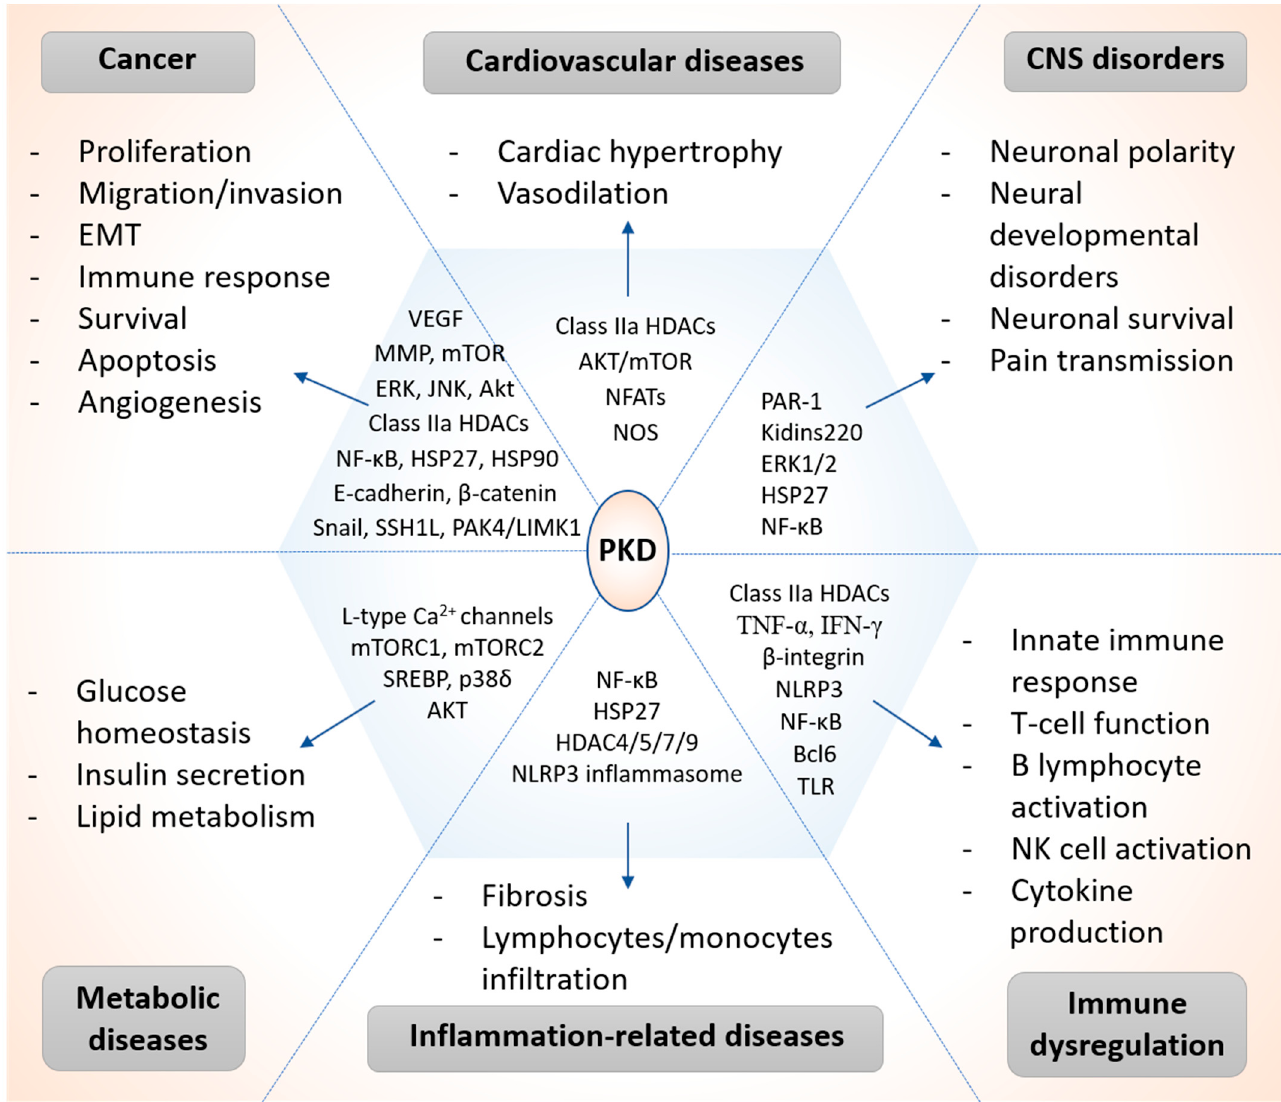
Figure 3. Versatile roles of PKD in human diseases. Schematic representation of key roles and major signaling targets of PKD in the pathogenesis of cancer and other human diseases. Abbreviations: central nervous system (CNS), epithelial-to- mesenchymal transition (EMT), natural killer (NK) cell, Toll-like receptor (TLR), nuclear factor of activated T cells (NFATs), sterol regulatory element binding protein (SREBP).